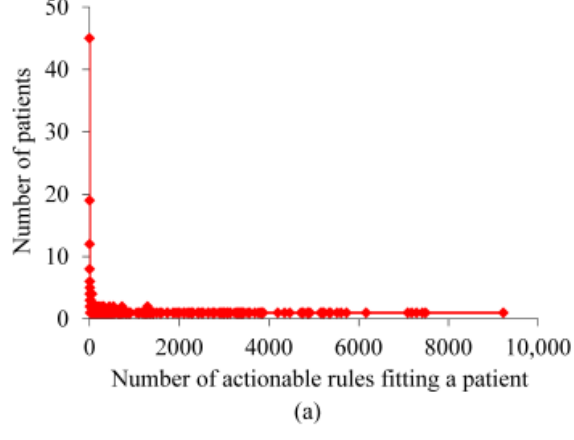
Figure 3. Distribution of patients by the number of actionable rules fitting a patient for the patients with asthma whom our extreme gradient boosting model correctly predicted to incur asthma hospital visits in the subsequent year. (a) When no limit is placed on the number of actionable rules fitting a patient. (b) When the number of actionable rules fitting a patient is ≤ 250.